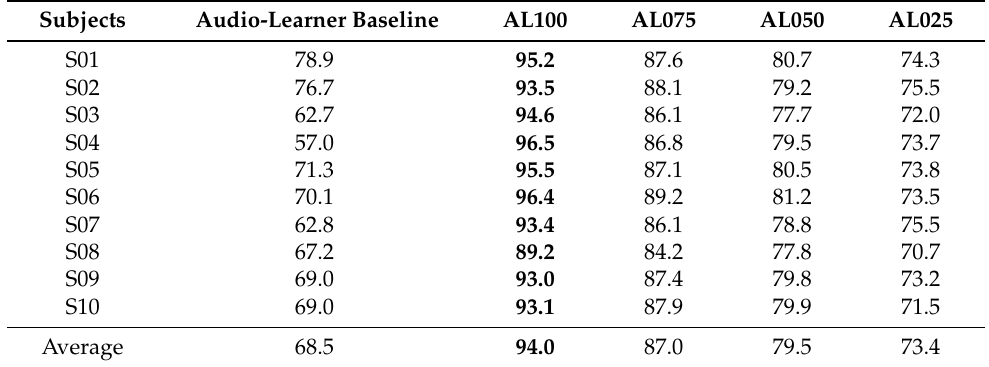
Table 10. Relationship to compare the performance of the audio average classification (expressed in percentage) model in contrast to the baseline and the four different alternatives over the AL approach.